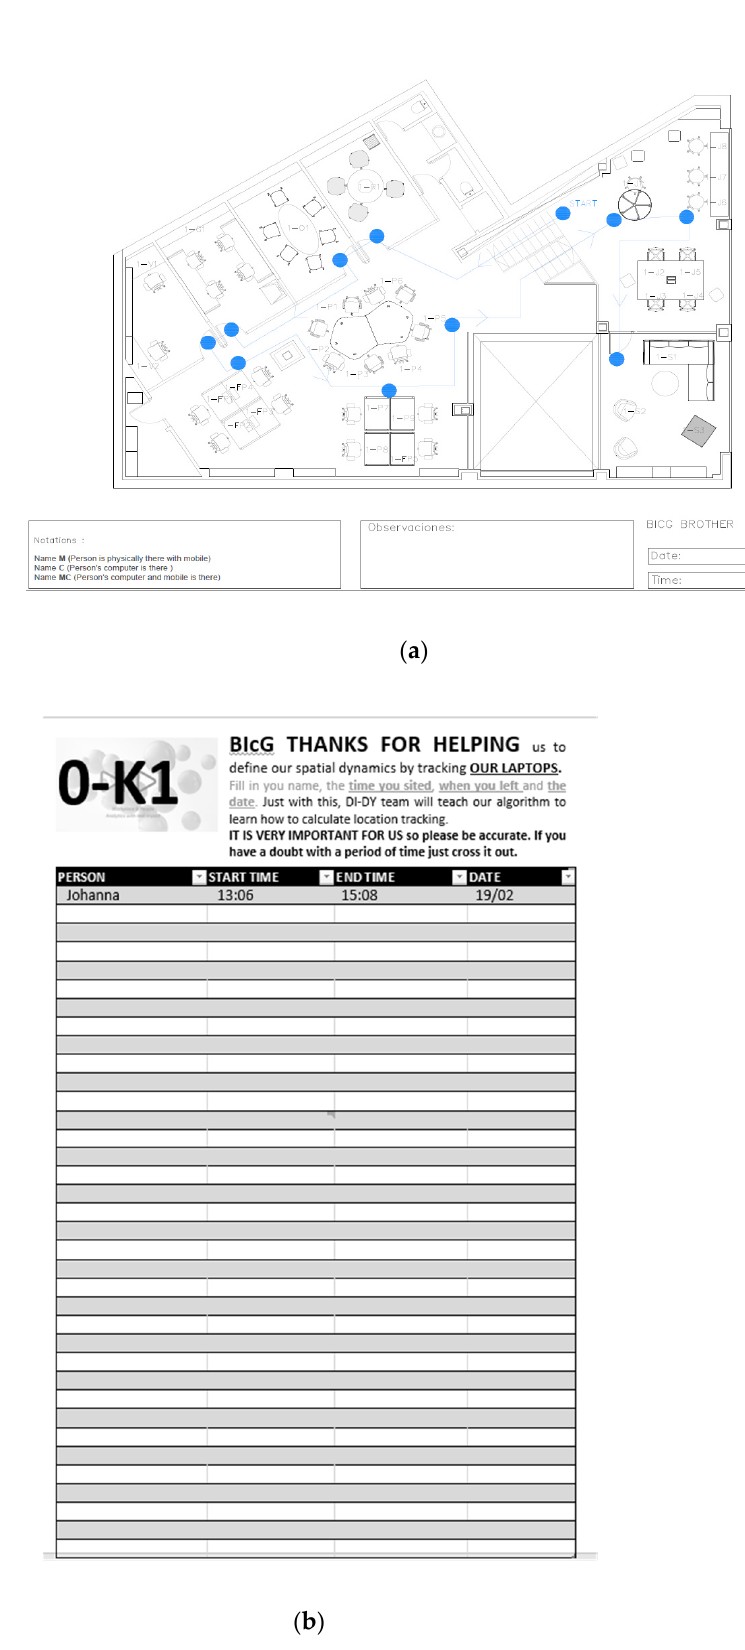
Figure 7. ( a ) Example of the walkthrough path sheet. ( b ) Blank register sheets from the